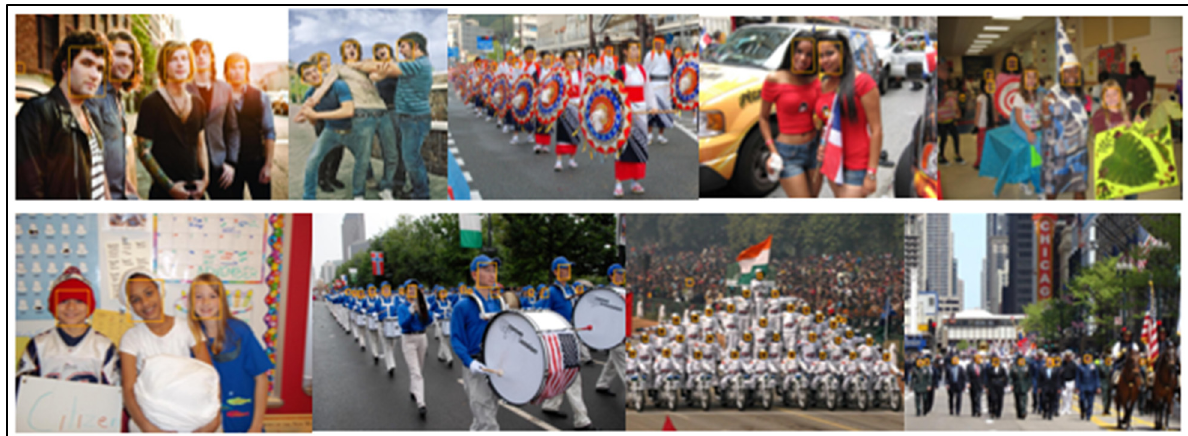
Figure 7. Scale images results (WIDER FACE dataset).